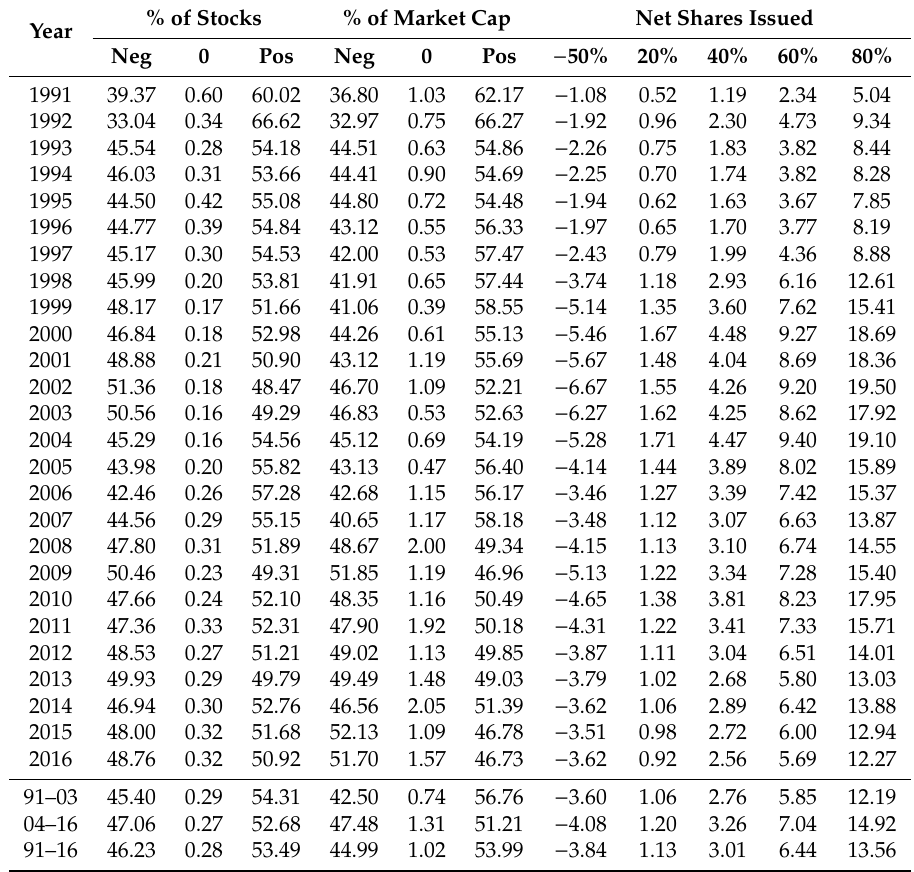
Table 11. Net Shares Issues—Japan 1991–2016. For Japan, net share issues (the number of shares issued minus repurchased) are computed for all stocks on an annual basis. Columns 2–4, % of Stocks, list the fraction of all stocks that are net repurchasers (Neg), net issuers (Pos) and that have zero net issues (0). Columns 5–7, % of Market Cap, list the percent of total market capitalization of net repurchasers, net issuers, and firms that don’t repurchase or issue. The last five columns list the median percent share repurchase ( − 50%), as well as the quintile breakpoints for issues. The last three rows provide averages over the full sample, ‘91–16’, and over two subperiods, ‘91–03’ and ‘04–16’. % of